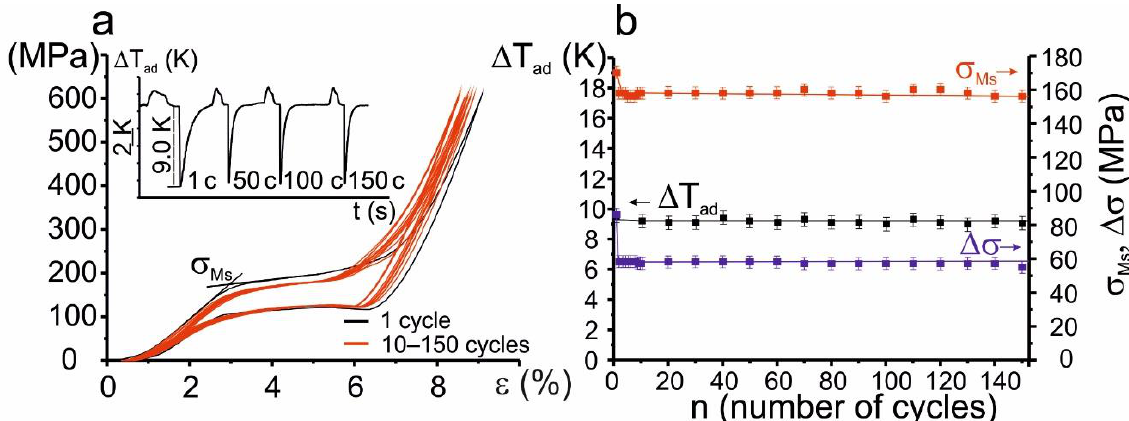
Figure 7. Compressive functional fatigue responses and EC fatigue at T = 323 K in aged at 773 K, 1 h Ni 54 Fe 19 Ga 27 single crystals, oriented along the [001]-direction: the dependence of SE curves with corresponding thermograms on number of cycles ( a ) and the dependence of adiabatic temperature change ΔT ad, critical stresses of forward MT σ Ms and stress hysteresis Δσ on number of cycles ( b ).